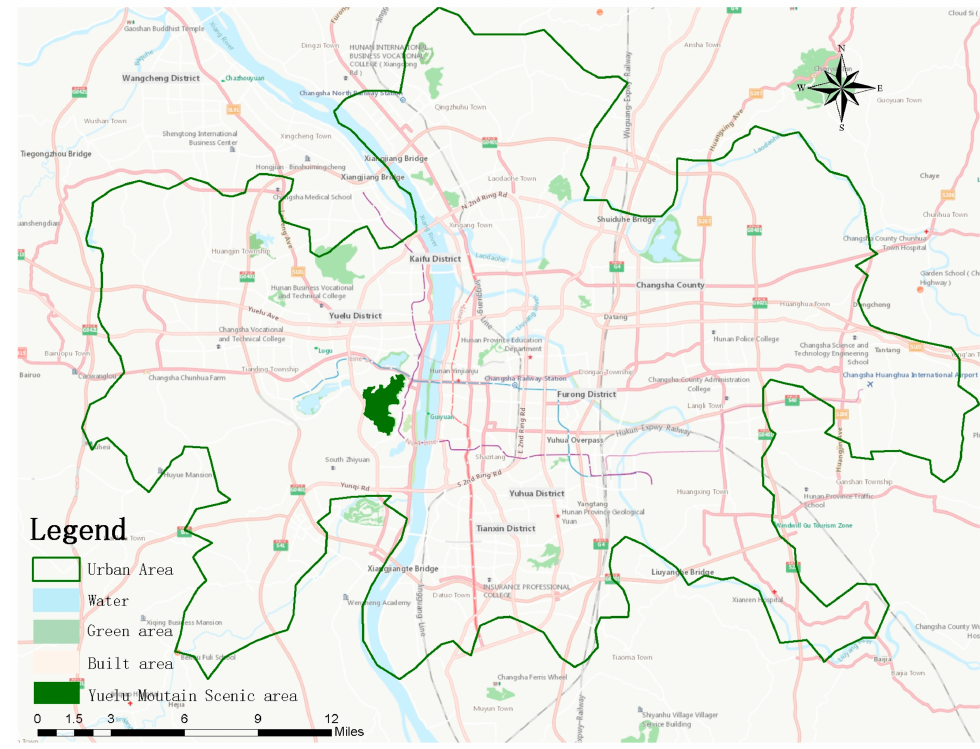
Figure 2. Overview of the urban area of Changsha